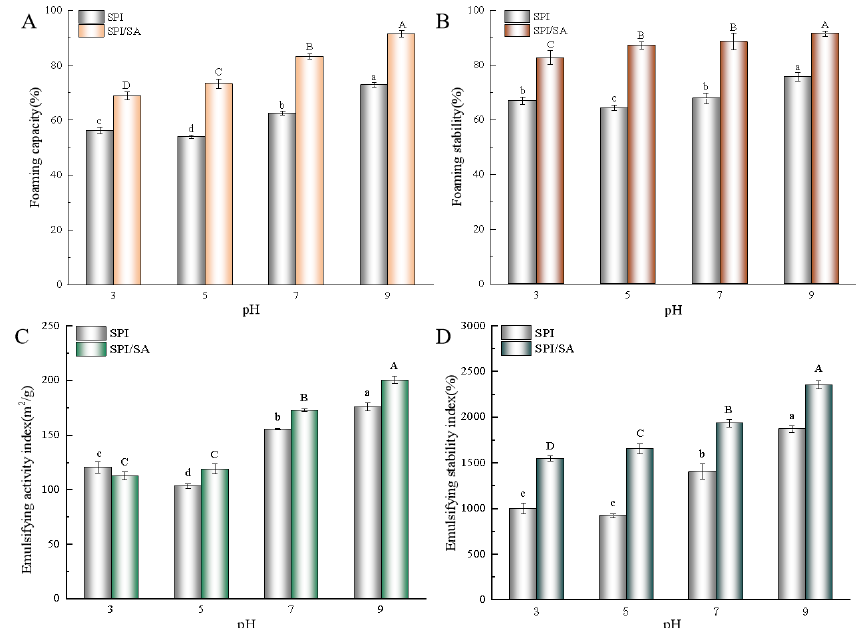
Figure 6. Foaming capacity (FC) ( A ), foaming stability (FS) ( B ), emulsifying activity index (EAI) ( C ), and emulsifying stability index (ESI) ( D ) of SPI and SPI/SA microparticles at different pH values. Different lowercase letters (a–d) within a column for each SPI/SA microparticles are significantly different ( p < 0.05). Different capital letters (A–D) within a column for each SPI microparticles are significantly different ( p < 0.05).